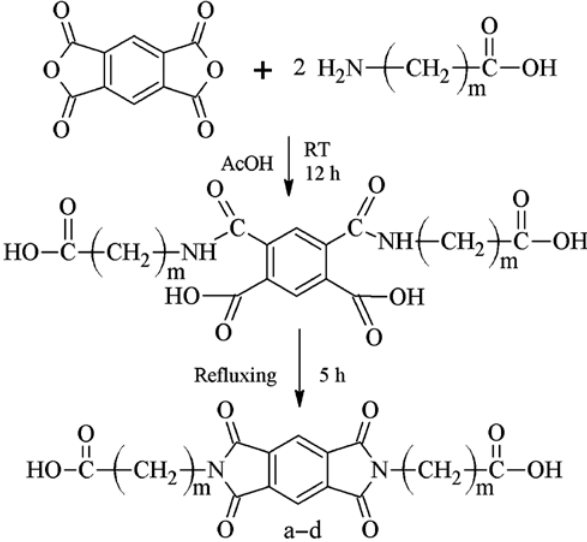
Figure 1: Synthesis of diacid monomers (a – d). Monomer a: m = 1; b: m = 2; c: m = 3; d: m = 5.